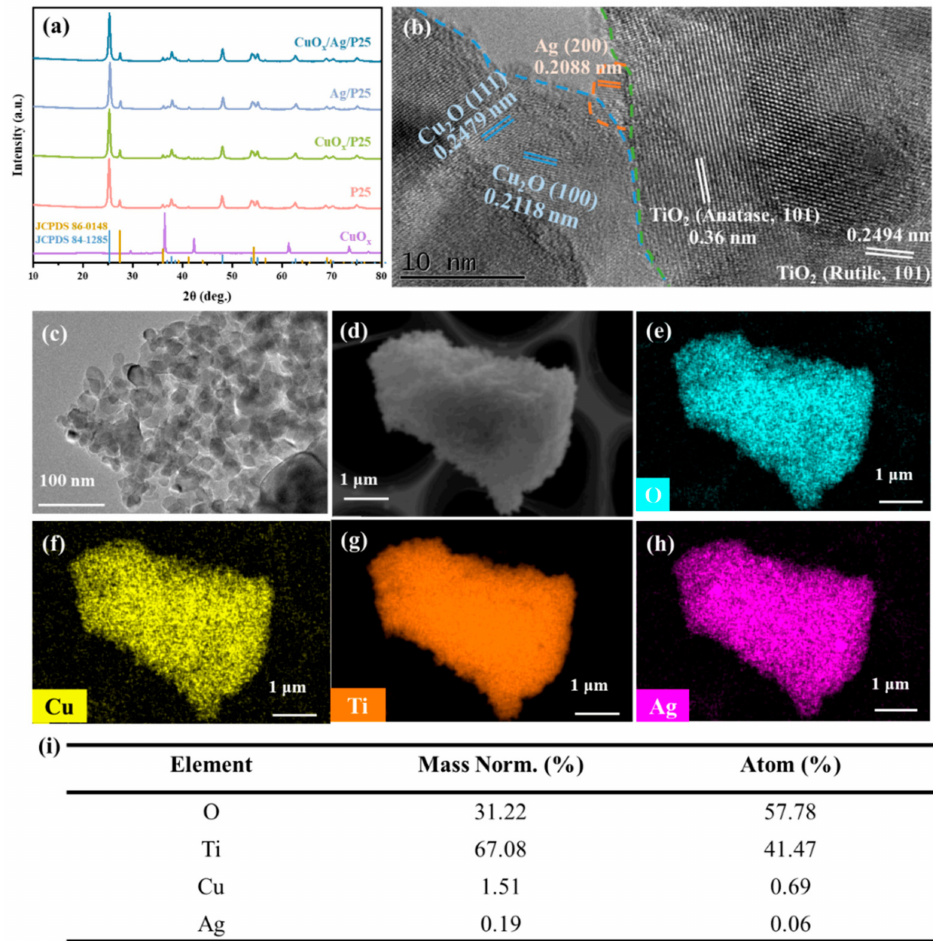
Figure 1. ( a ) XRD patterns of P25, CuO x , CuO x /P25, Ag/P25, and CuO x /Ag/P25; ( b ) HRTEM and ( c ) TEM images of CuO x /Ag/P25; ( d – h ) EDS element mapping images of CuO x /Ag/P25; ( i ) list of element content of CuO x